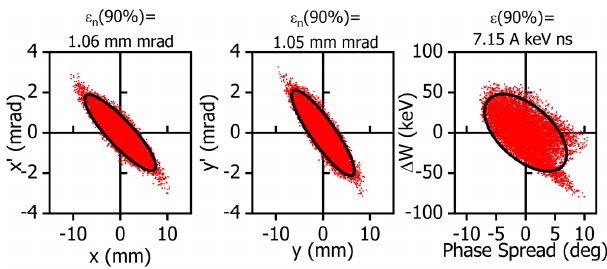
FIG. 27. The rms emittance growth and average losses for quadrupole singlet displacement along the